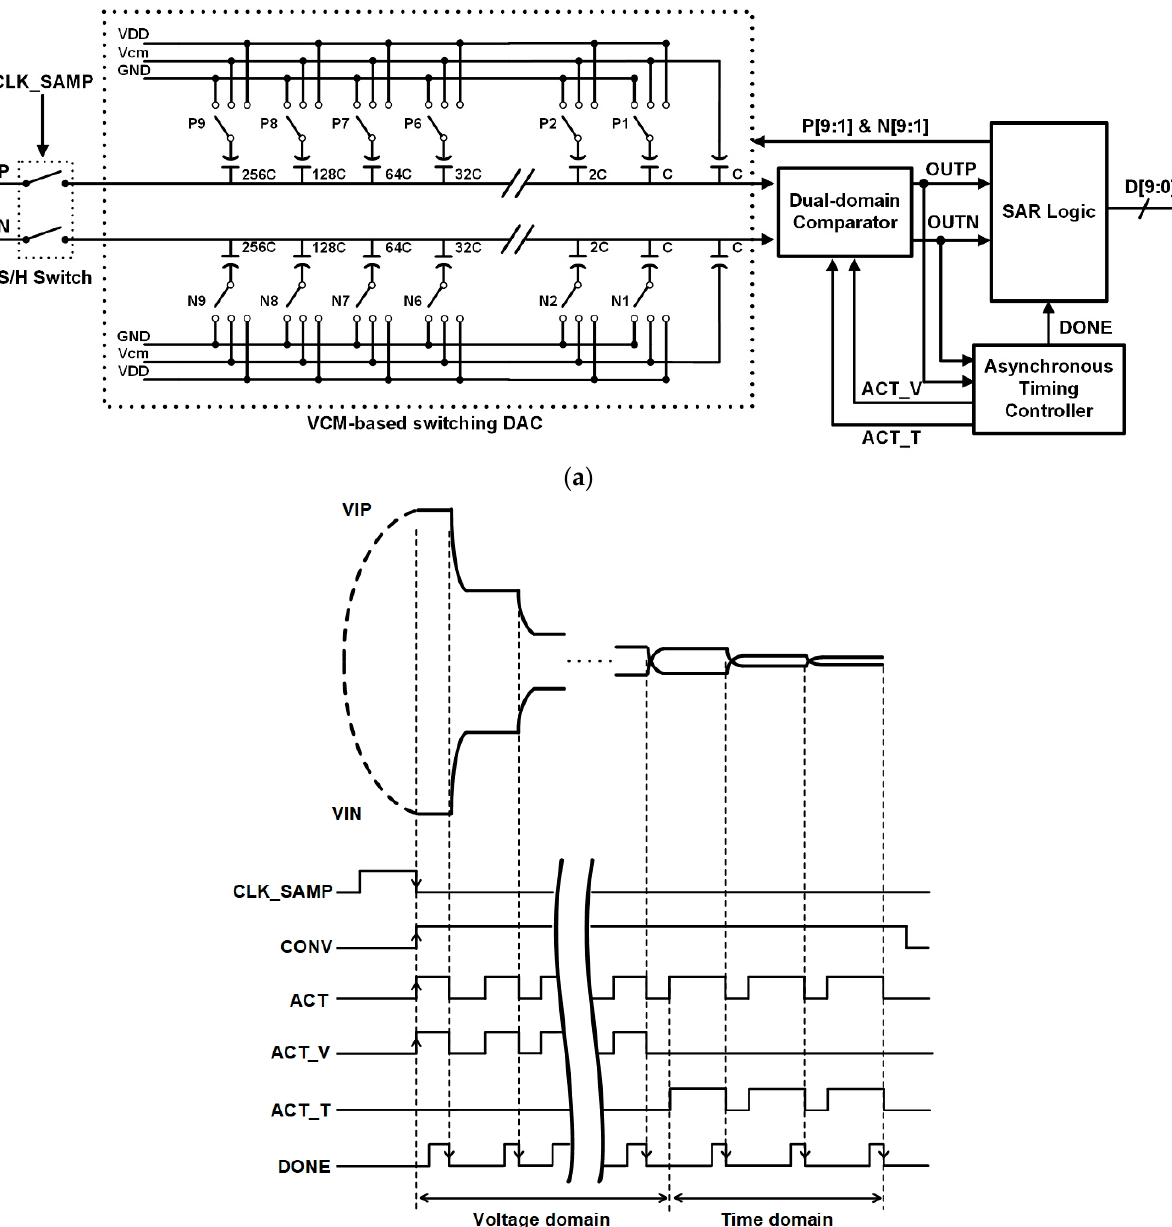
Figure 2. ( a ) Architecture of the proposed SAR ADC; ( b ) Timing diagram of the proposed SAR ADC.